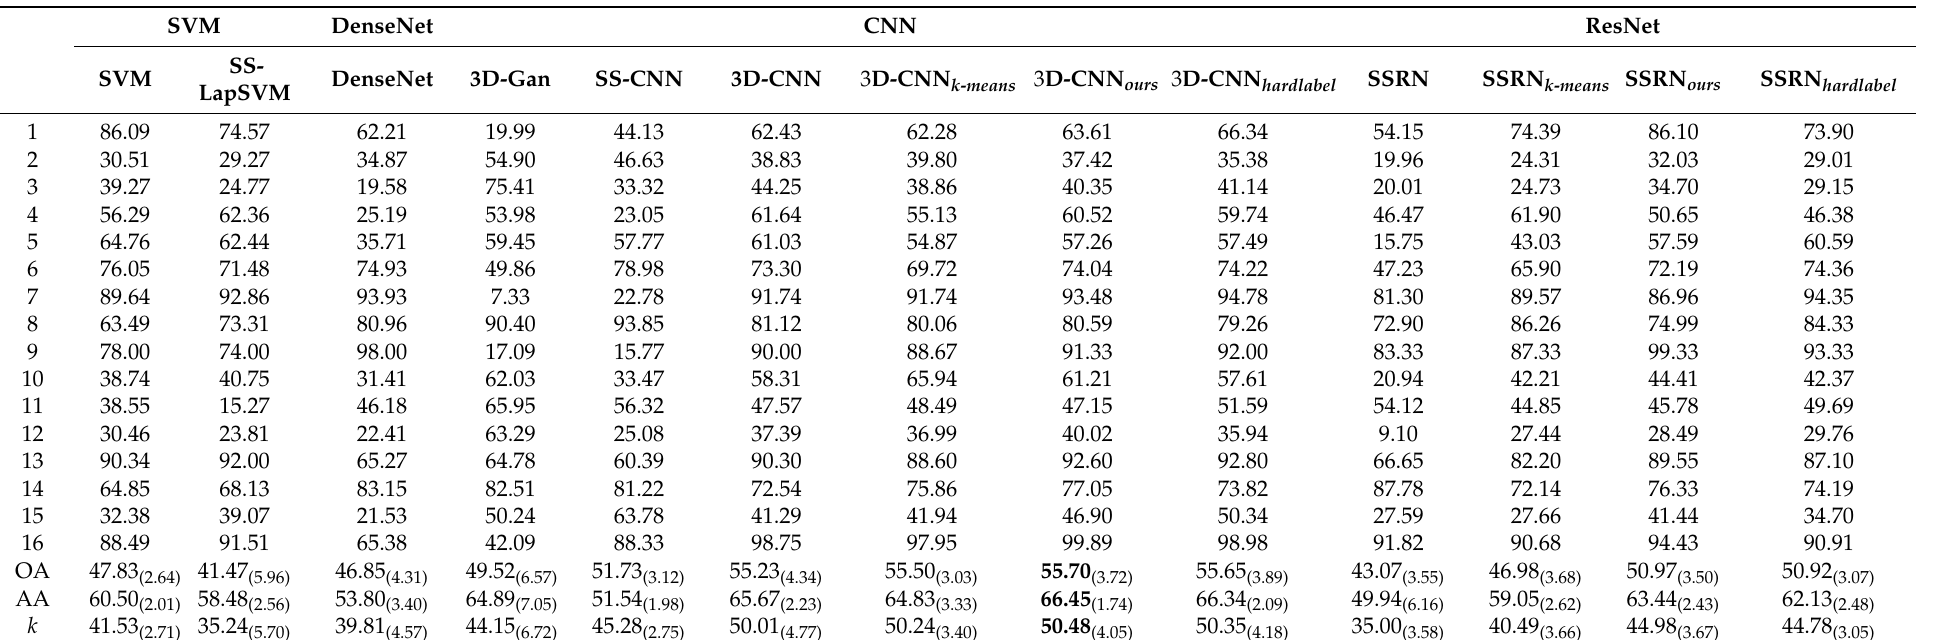
Table 7. Classification accuracy (%) for all methods with five training samples on the Indian Pines